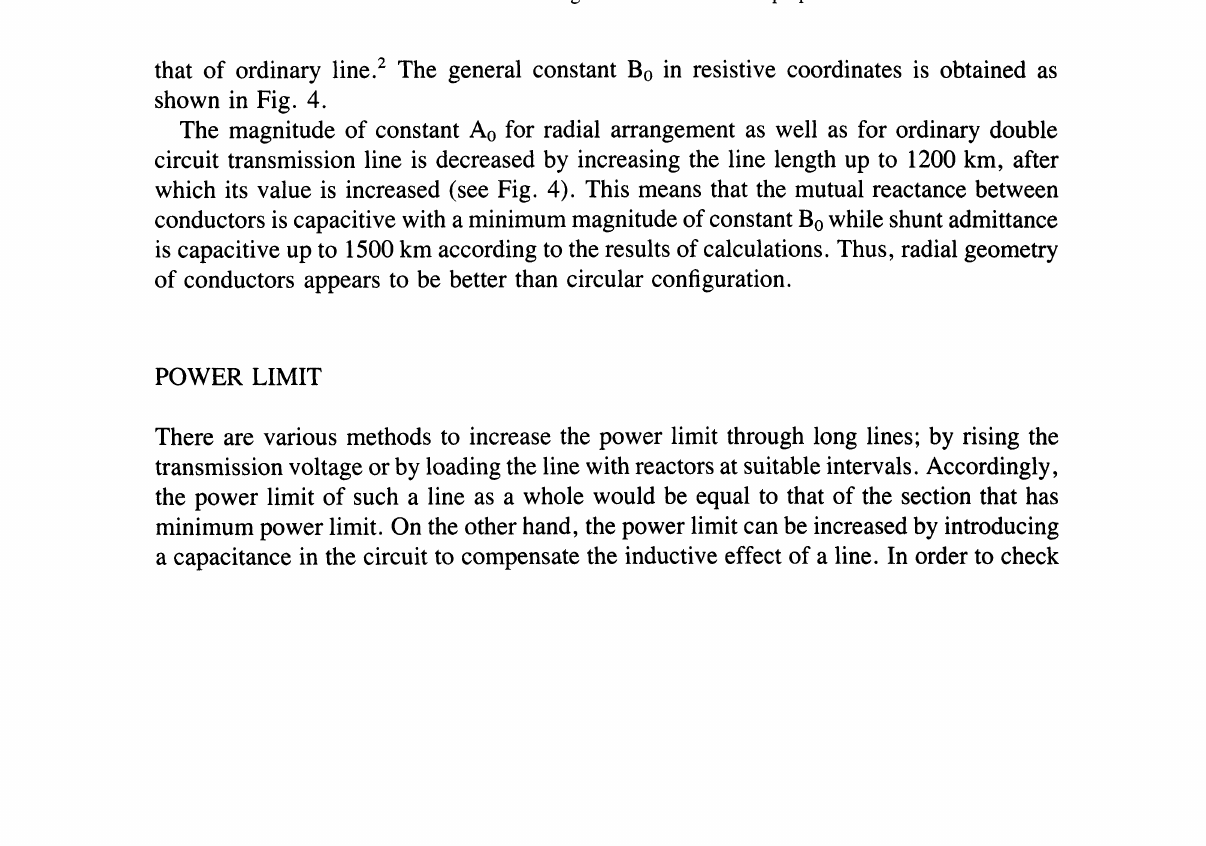
FIGURE 4 The calculated general constants of the proposed